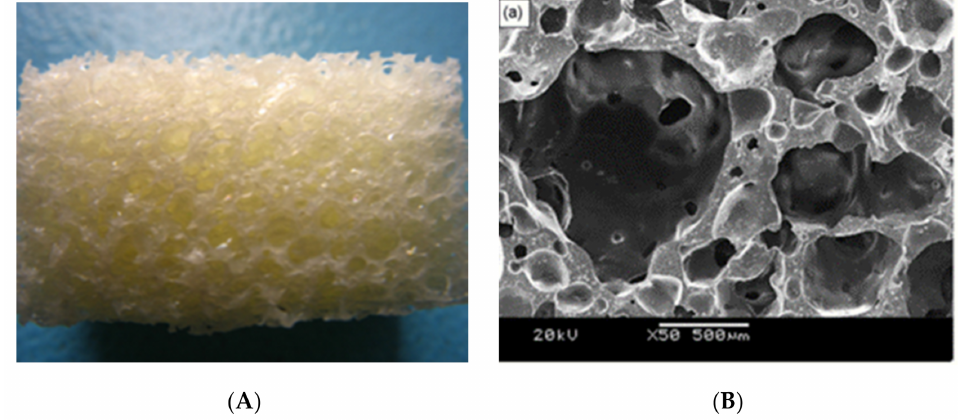
Figure 11. ( A ) Photo macrograph of the porous PU/HAp scaffold; ( B ) SEM photographs of the porous PU/HAp scaffold. Reprinted from [135] with permission from